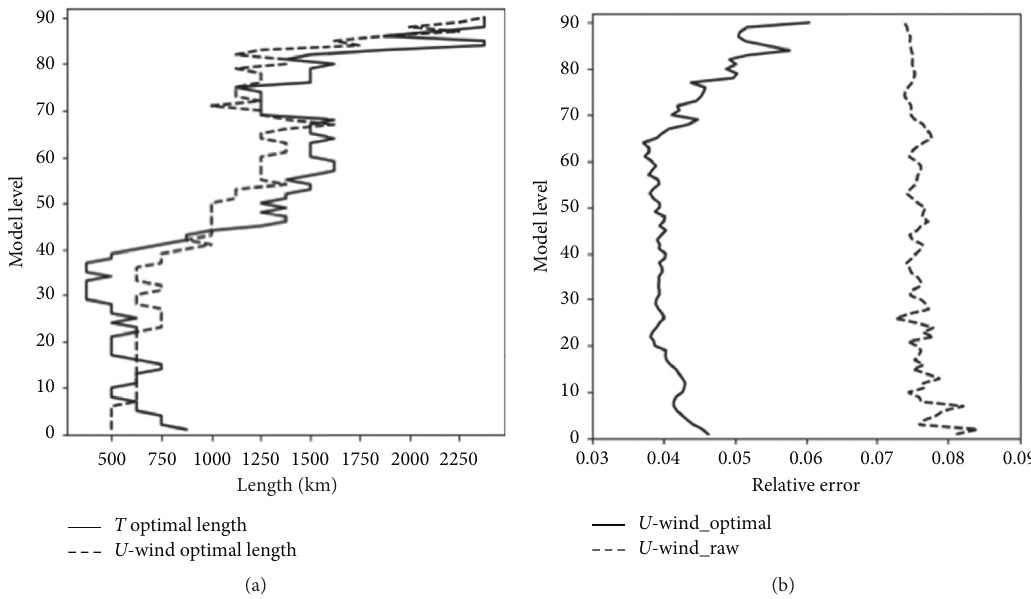
Figure 10: (a) The optimal length for temperature and U -wind by the vertical model level. (b) The relative error of U -wind raw estimates and optimal filtering results.